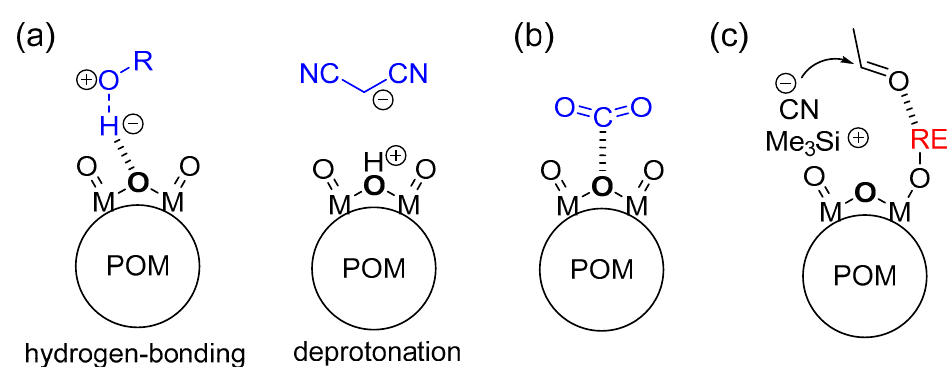
Figure 9. Schematic representations for activation of substrates by POM base catalysts. ( a ) Abstraction of protons (Brønsted base), ( b ) nucleophilic action to substrates (Lewis base), and ( c ) bifunctional action in combination with metal catalysts.